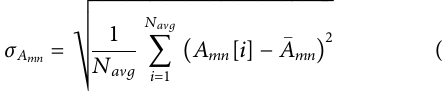
Frontiers in Energy Research |